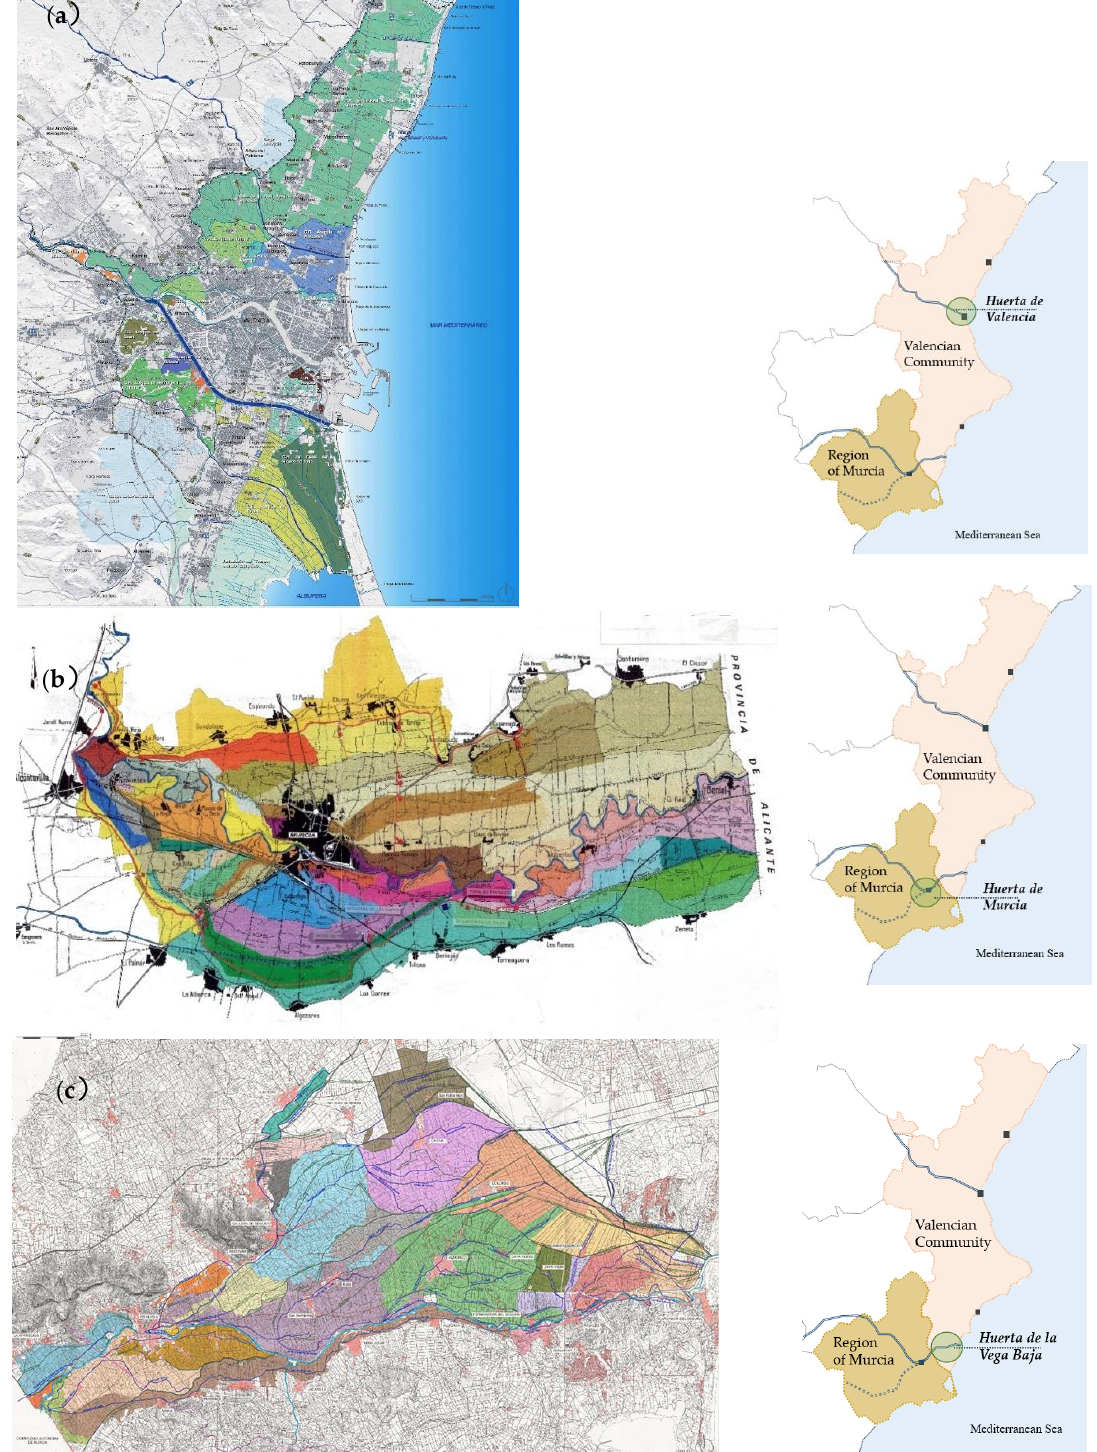
Figure 7. Irrigation Communities in each Huerta territories. ( a ) Huerta de Valencia . Each colour represents an irrigation community related to a Major Canal [28]; ( b ) Huerta de Murcia . Breakdown of the Irrigation Community into the smaller irrigation management areas as indicated by map colouring [49]; ( c ) Irrigation Communities of Huerta de la Vega Baja [59].